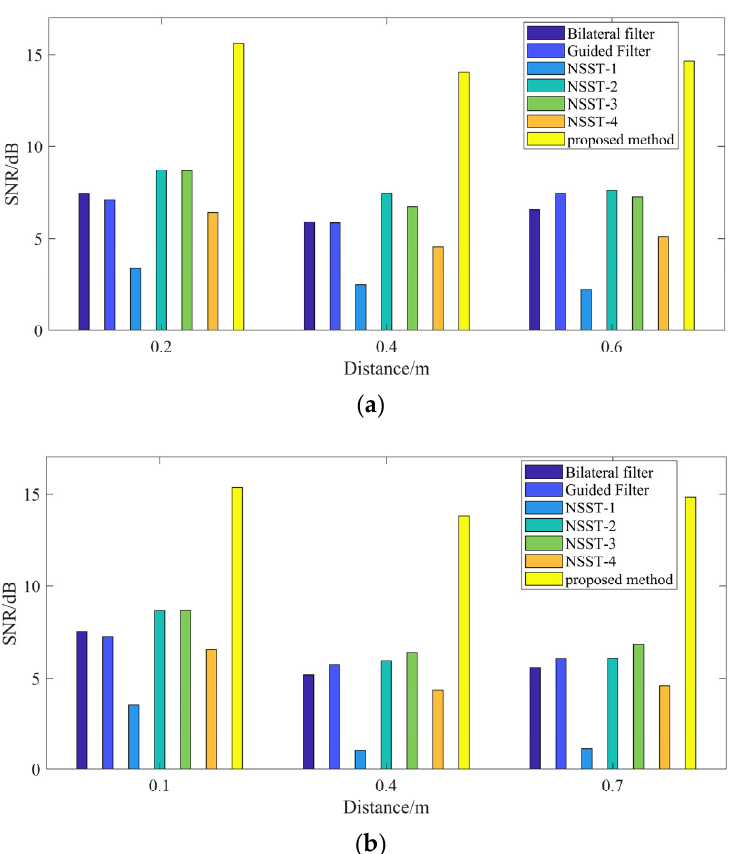
( h ) Figure 9. ( a ) The simulated noisy GPR image 2. ( b ) The result of bilateral filter. ( c ) The result of guided filter. ( d ) The result of NSST-1. ( e ) The result of NSST-2. ( f ) The result of NSST-3. ( g ) The result of NSST-4. ( h ) The result of the proposed